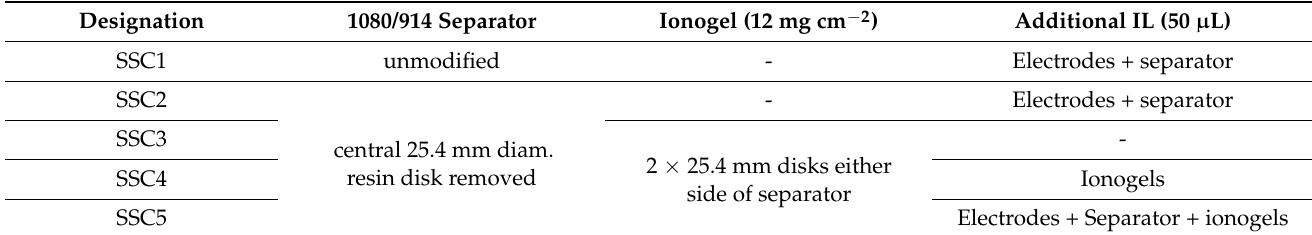
Table 1. Structural supercapacitor configurations